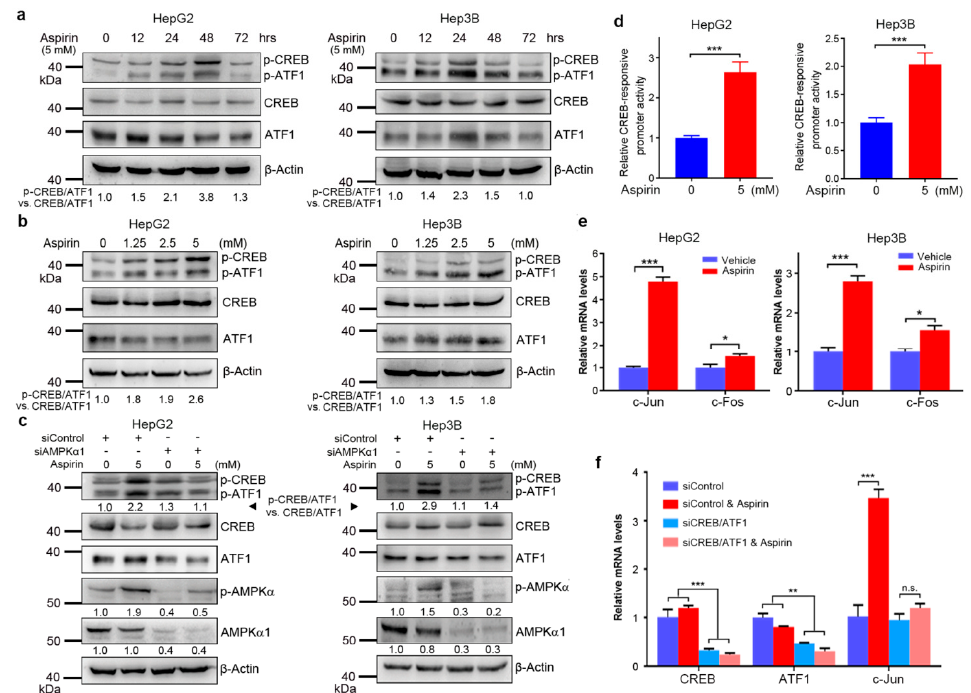
Figure 1. Aspirin induces (PKA)-cAMP response element-binding protein (CREB /ATF1) activation through AMP-activated protein kinase (AMPK). ( a ) HepG2 and Hep3B cells were treated with aspirin for indicated periods, followed by western blot analysis with indicated antibodies. The relative levels of p-CREB/ATF1 normalized to total CREB/ATF1 were shown. ( b ) HepG2 and Hep3B cells were treated with indicated doses of aspirin for 32 h, followed by western blot analysis with indicated antibodies. The relative levels of p-CREB/ATF1 normalized to total CREB/ATF1 were shown. ( c ) HepG2 and Hep3B cells were transfected with siControl or siAMPK α 1 and treated with or without aspirin for 32 h, followed by western blot analysis with indicated antibodies. The relative levels of p-CREB/ATF1 normalized to total CREB/ATF1, and the relative levels of p-AMPK and AMPK α 1 normalized to β -actin were shown. ( d ) HepG2 and Hep3B cells were transfected with the CREB luciferase reporter plasmid and the renilla luciferase plasmid, followed by treatment with or without aspirin for 24 h. The luciferase activities were measured using a dual-luciferase reporter assay kit. The CREB-responsive promoter activity was normalized by the renilla luciferase values. The relative CREB-responsive promoter activity was plotted. Values represent means ± SD ( n = 4). ***, p < 0.001. ( e ) HepG2 and Hep3B cells were treated with or without 5 mM aspirin for 48 h, followed by real-time RT–PCR analysis of c-Jun and c-Fos transcription. The relative mRNA levels were plotted. Values represent means ± SD ( n = 3). *, p < 0.05, ***, p < 0.001. ( f ) HepG2 cells were transfected with siControl or siCREB/ATF1 and treated with or without 5 mM aspirin, followed by real-time RT–PCR analysis of indicated genes. The relative mRNA levels were plotted. Values represent means ± SD ( n = 3). **, p < 0.01. ***, p < 0.001. n.s. , not significant.